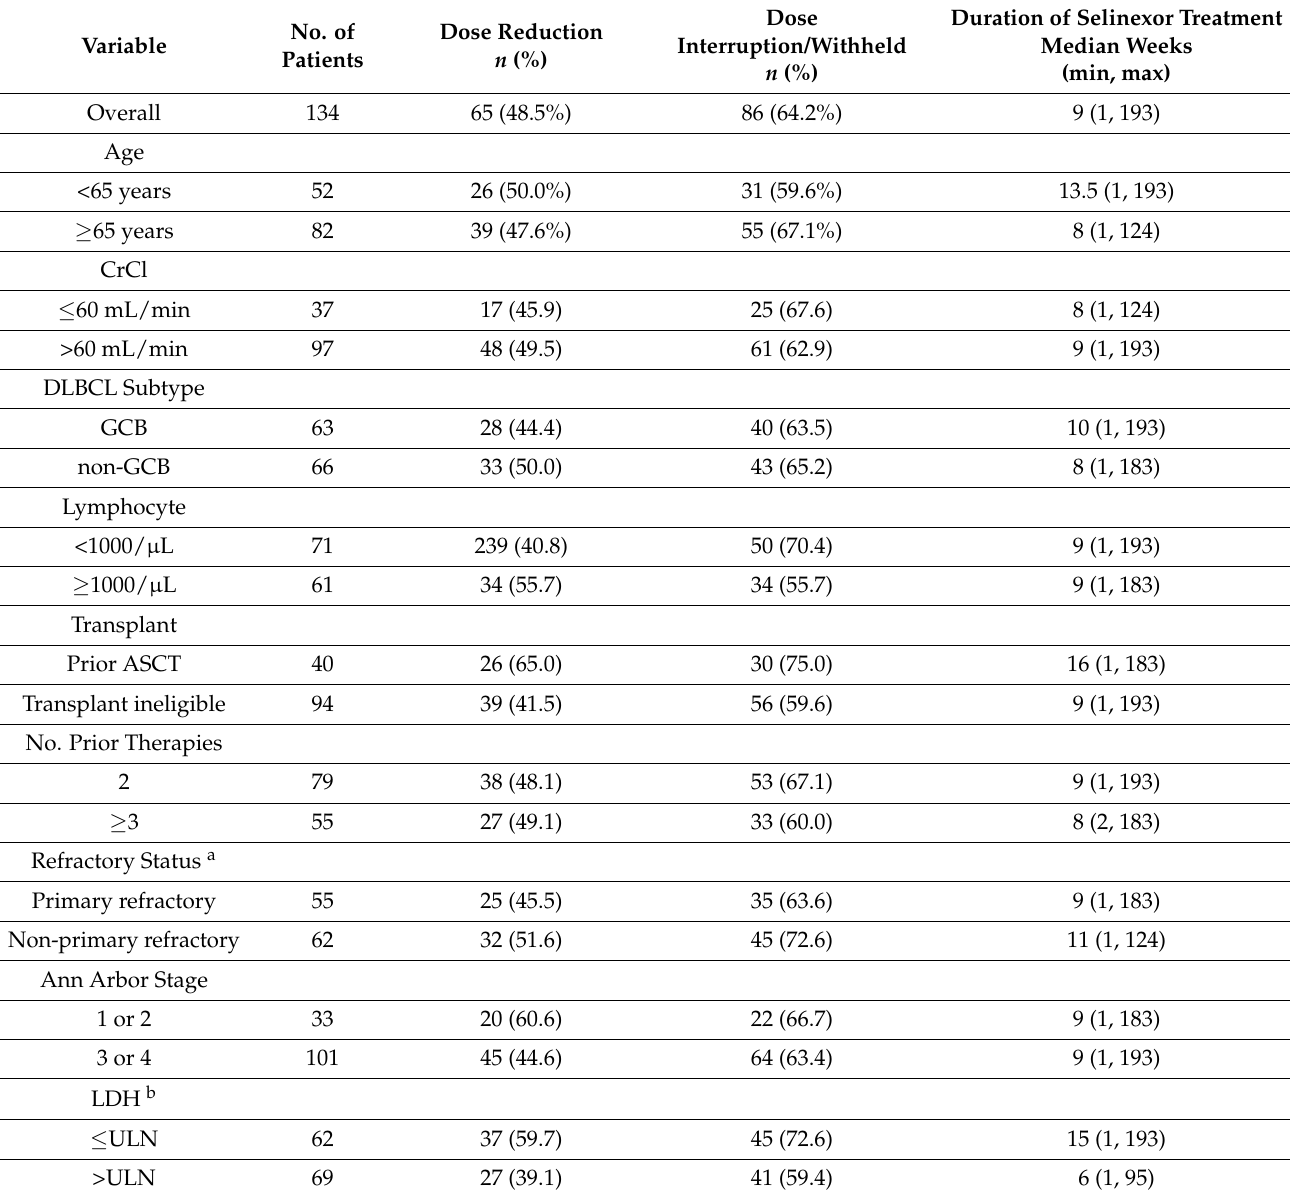
Table 4. Summary of selinexor reduction, interruption, and